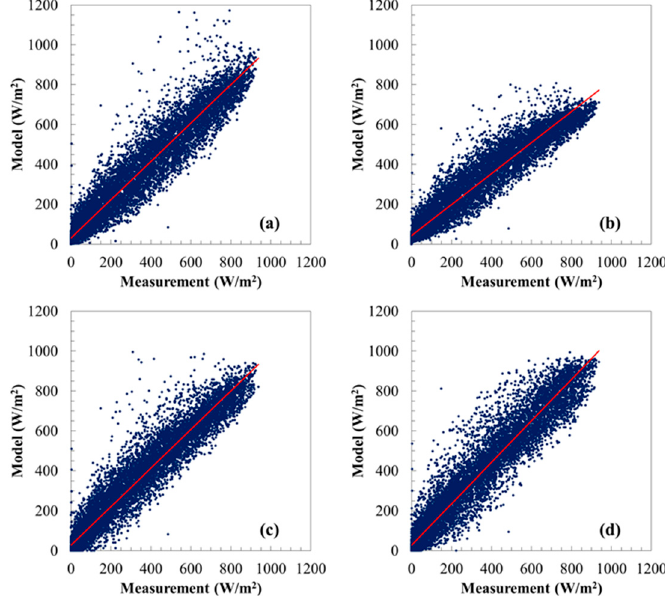
Figure 1. Scatterplots of direct normal irradiance (DNI) measurements and estimations, in which the red curves represent the linear regression fits: ( a ) Vignola; ( b ) Lee; ( c ) Reindl-2; and ( d ) Maxwell.